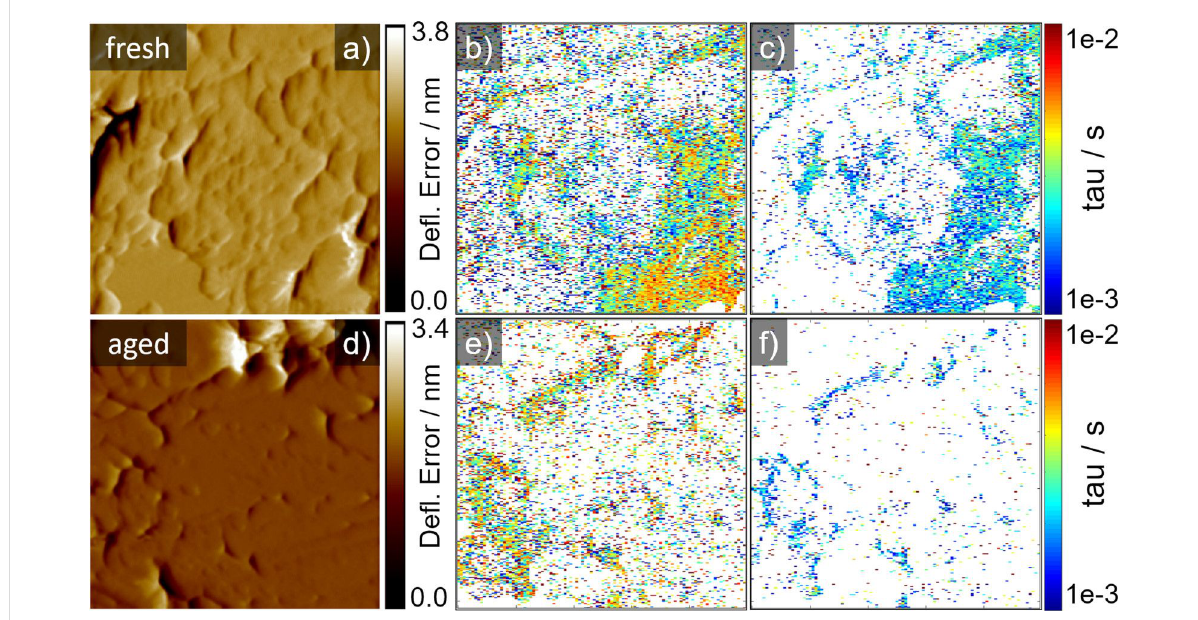
Figure 7: Fitted time constants from Figure 5 of a fresh (top row) and aged cathode (bottom row) cross-section. a) and d) show the deflection error, b) and e) the time constants during positive and c) and f) during negative voltage pulse. Scan size is 1 × 1 µm 2 .